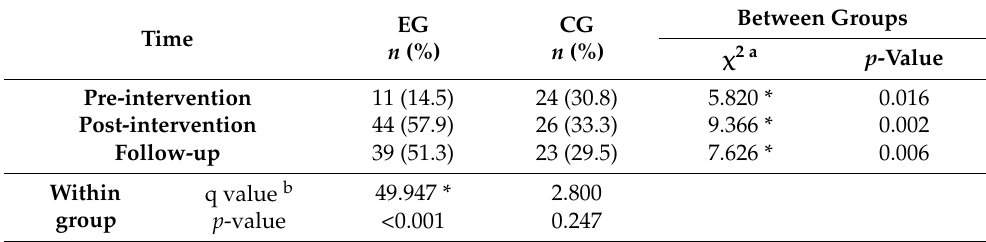
Between Groups EG CG n (%) n (%) χ 2 a p -Value